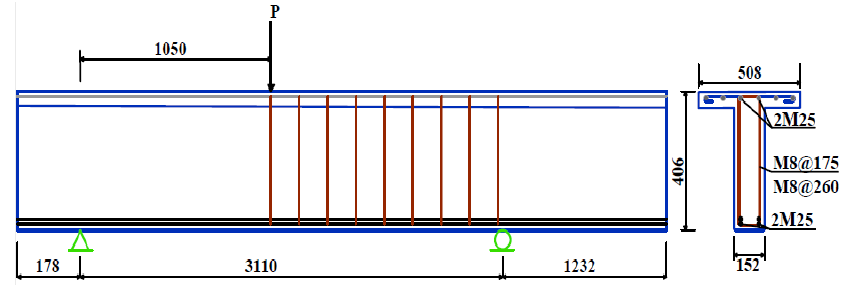
Figure 14. Detailed Geometry of Chaallal et al. Control Specimens (CON-S0, CON-S1, CON-S3) [53,54].